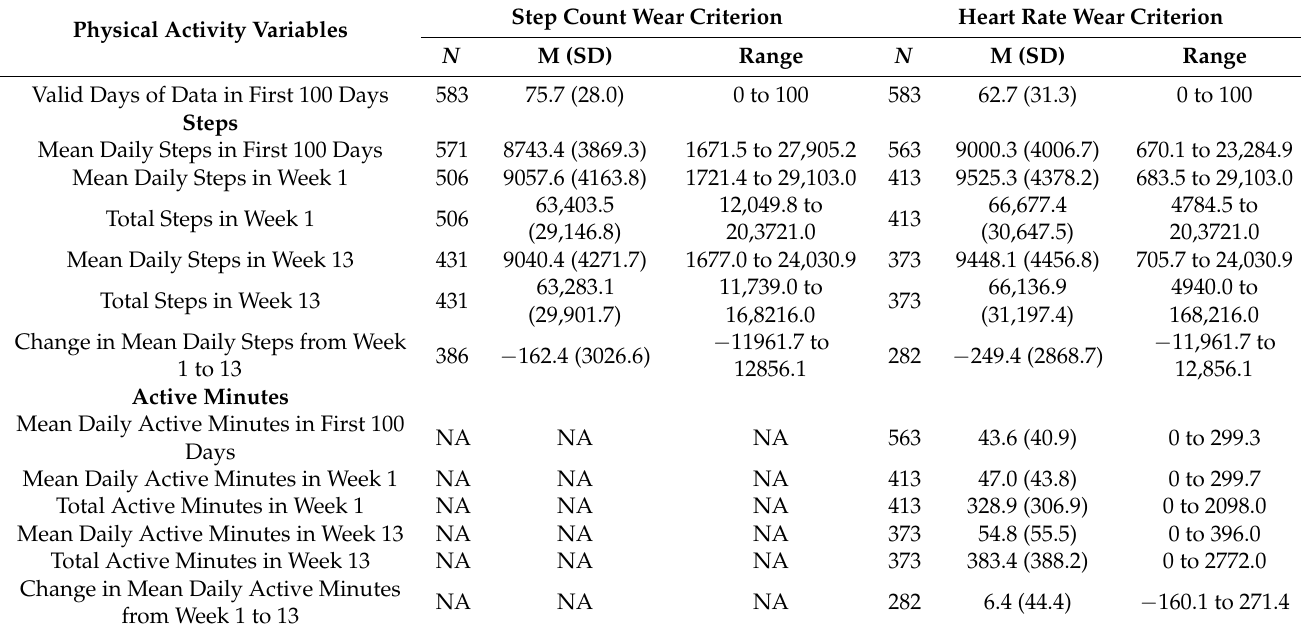
Table 2. Physical activity outcomes among participants with valid wear based on Step Count or Heart Rate